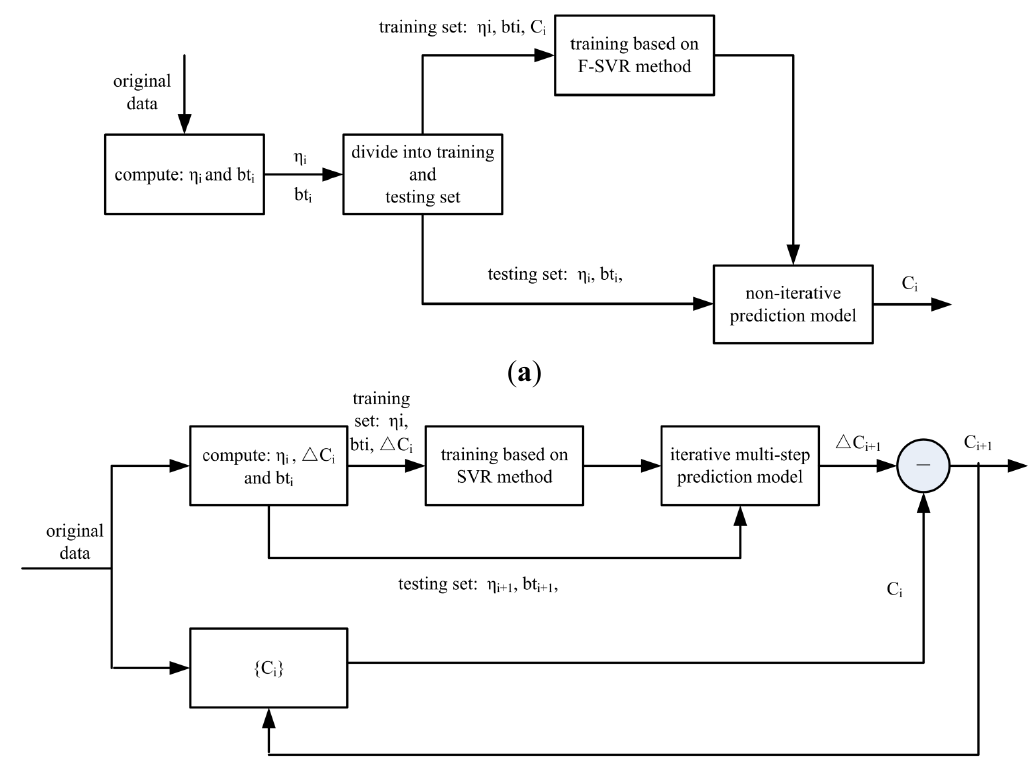
Figure 3. Battery RUL prediction model based on energy efficiency and the average working temperature: ( a ) the non-iterative prediction model based on the F-SVR method; and ( b ) the iterative multi-step prediction model based on the SVR